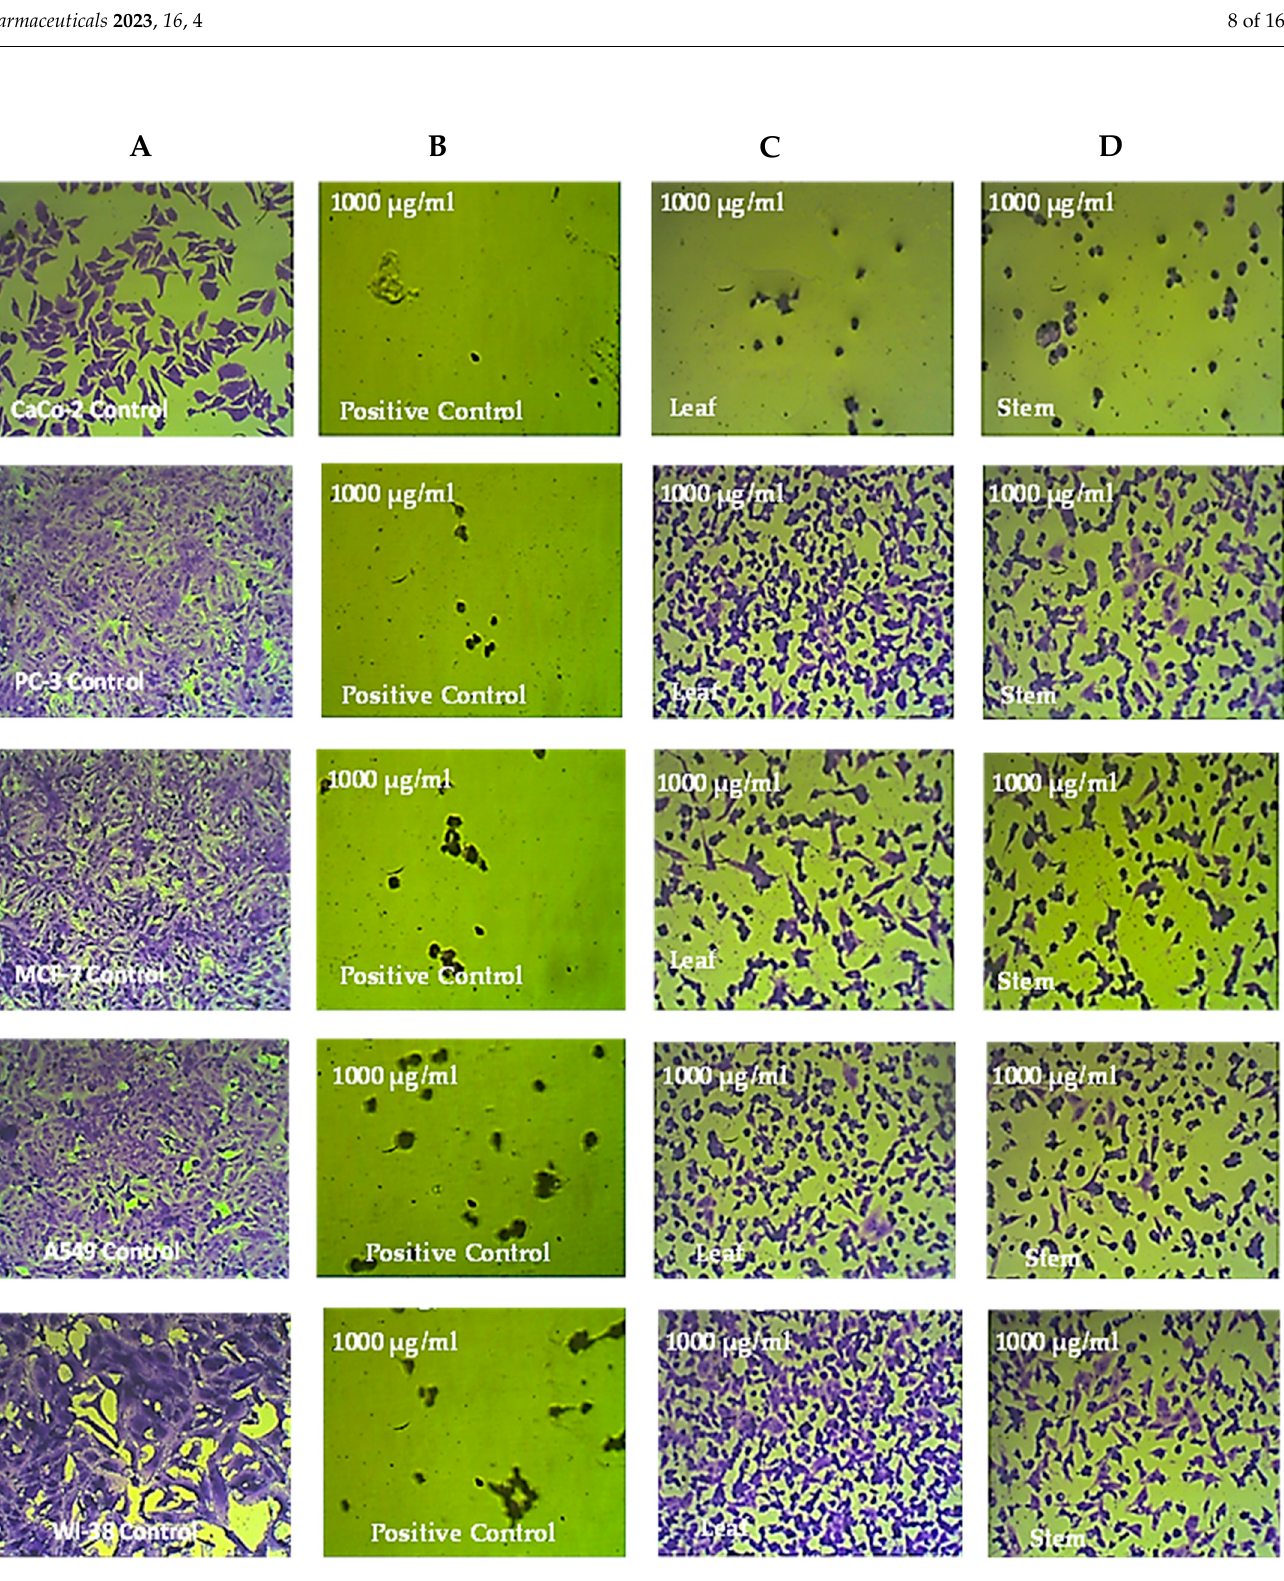
Figure 4. The anticancer effects of R. micronata stem and leaf extracts in methanol on cancer cell lines. ( A ) Complete monolayer sheets are seen in all cancer cell lines that have not been treated. ( B ) Doxorubicin treatment results in rounded and shrunken cells in all cancer cell lines. ( C ) Tiny, shrunken, and rounded cells are visible in CaCo ‐ 2, MCF ‐ 7, and A549 cell lines, as well as in PC ‐ 3 and WI ‐ 38 cell lines. ( D ) The methanol extract of R. micronata stem used to treat cancer cell lines revealed significantly rounded and shrunken cells in colon cancer (CaCo ‐ 2), breast cancer (MCF ‐ 7), and lung cancer (A549), as well as smaller, rounded, and shrunken cells in PC ‐ 3 and WI ‐ 38.